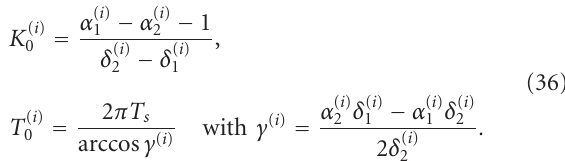
Embedded BOSCH controller Figure 7: Responses with the fuzzy PI and the standard embedded BOSCH